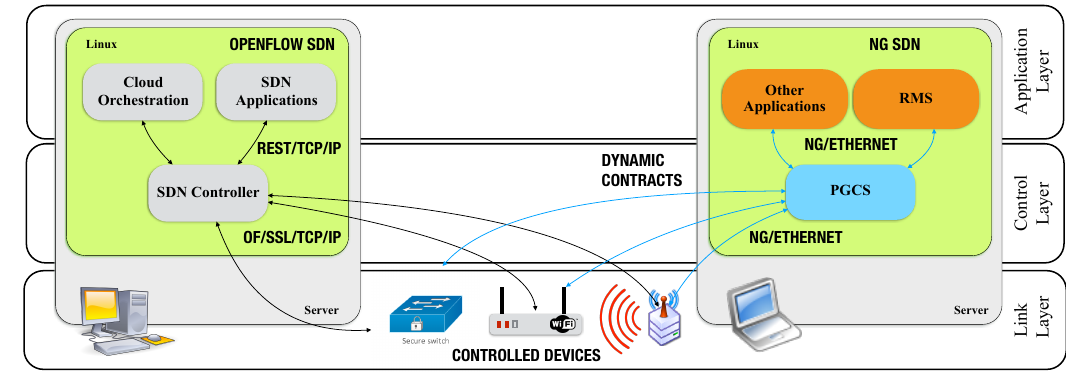
Figure 5. Comparison of OpenFlow-based SDN with NovaGenesis service-defined architecture